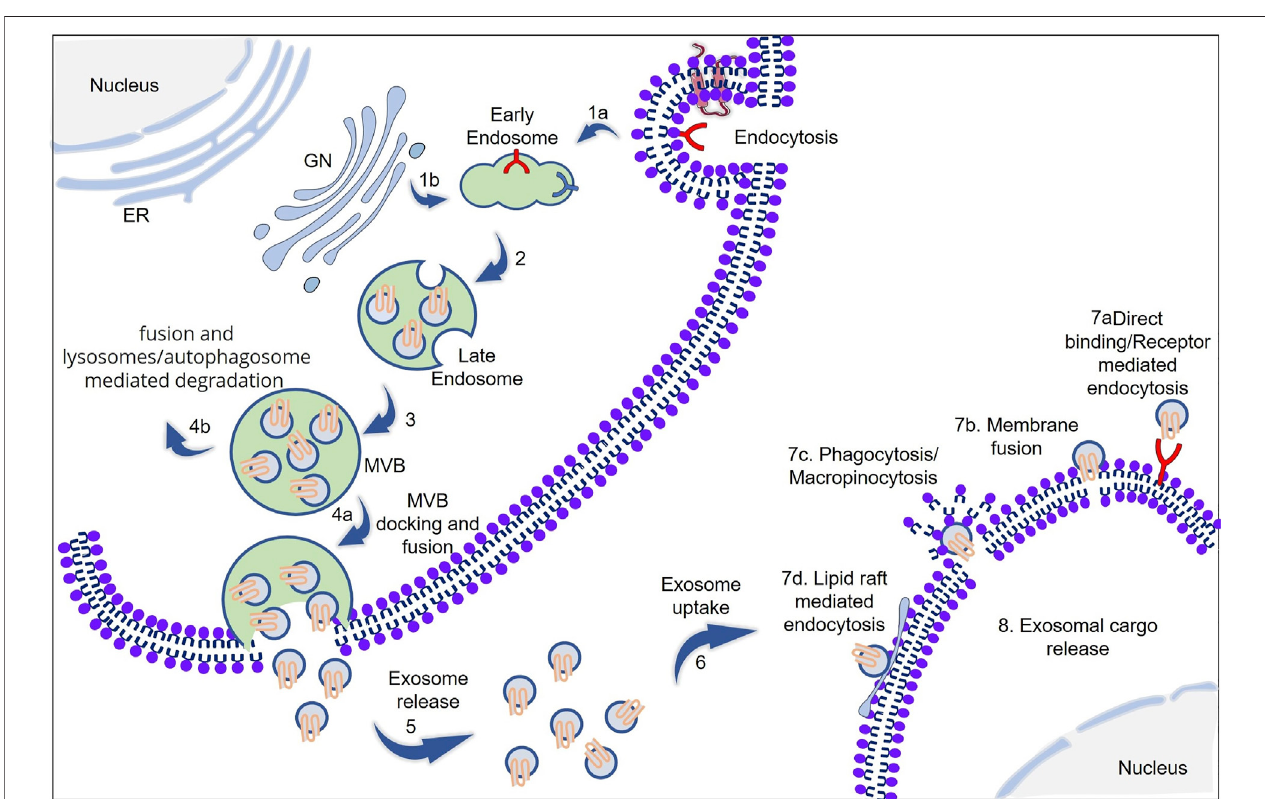
FIGURE1| Schematicrepresentationofexosome biogenesis,cargopacking,and cellular uptake. (1a,b) Earlyendosomesareformed from theinward budding of the plasma membrane or Golgi network (GN). (2,3) Early endosomes mature to form late endosomes and subsequently to multivesicular bodies (MVB). (4a) MVB dockingintotheplasmamembrane via SNAREsandSNAP23,andsubsequentfusionwiththeplasmamembraneresultsinexosomerelease (5) .Alternatively,MVBscan fuse with lysosome and subsequent degradation (4b) . (6) The released exosome will be taken up by the neighboring cell. The cellular uptake of exosomes can be (7a) directbindingandreceptor-mediatedendocytosis, (7b) membranefusion, (7c) phagocytosis/micropinocytosis,or (7d) lipidraft-mediatedendocytosis.TheESCRT machinery plays a key role in protein sorting, particularly for ubiquitinated cargos. During the process of exosome biogenesis, various proteins, including RNA-binding proteins (RBPs), are selectively sequestered into exosomes; these RBPs help in RNA cargo packing into the exosome. (ER: endoplasmic reticulum; GN: Golgi network; MVB: multivesicular bodies; ESCRT: endosomal sorting complex required for